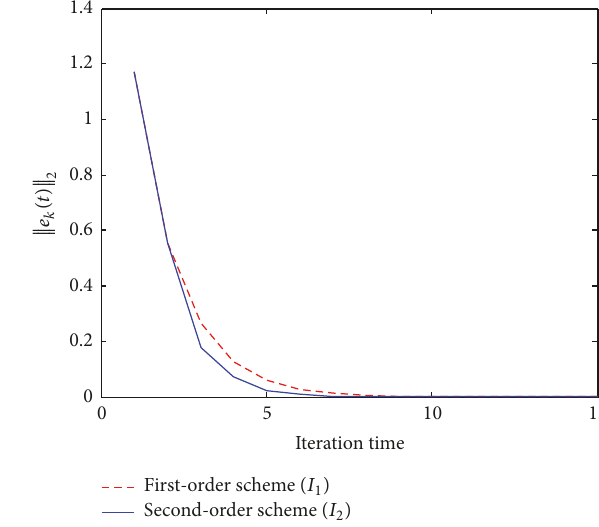
Figure 6: Comparison of tracking